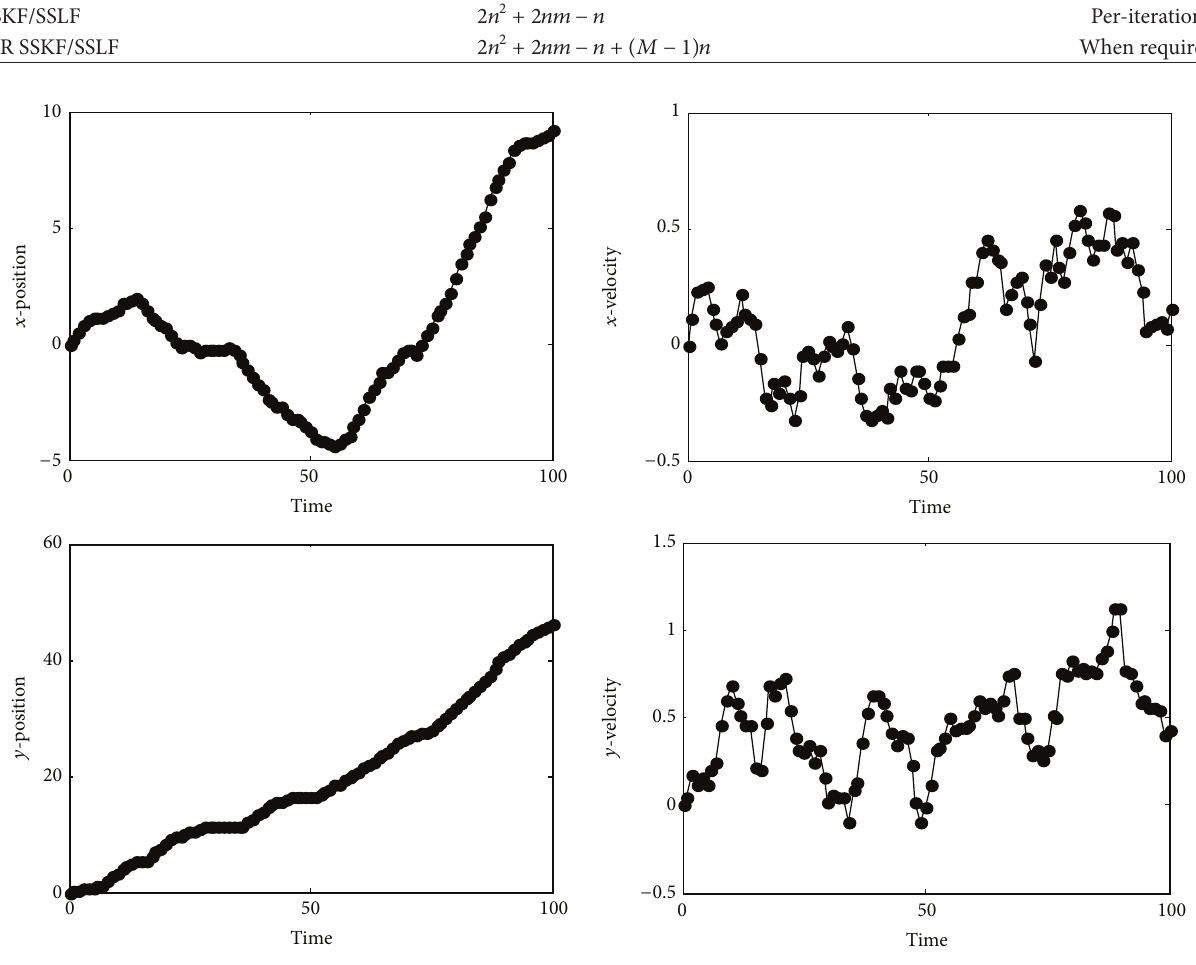
Figure 2: Position and velocity estimation solid line: SSKF/SSLF, dashed line: FIR